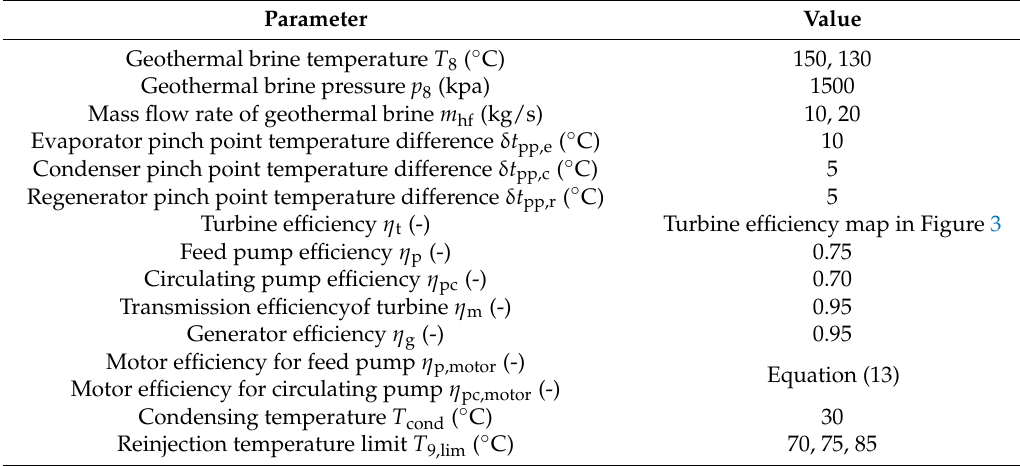
Table 1. System boundary conditions, fixed values and constraints.